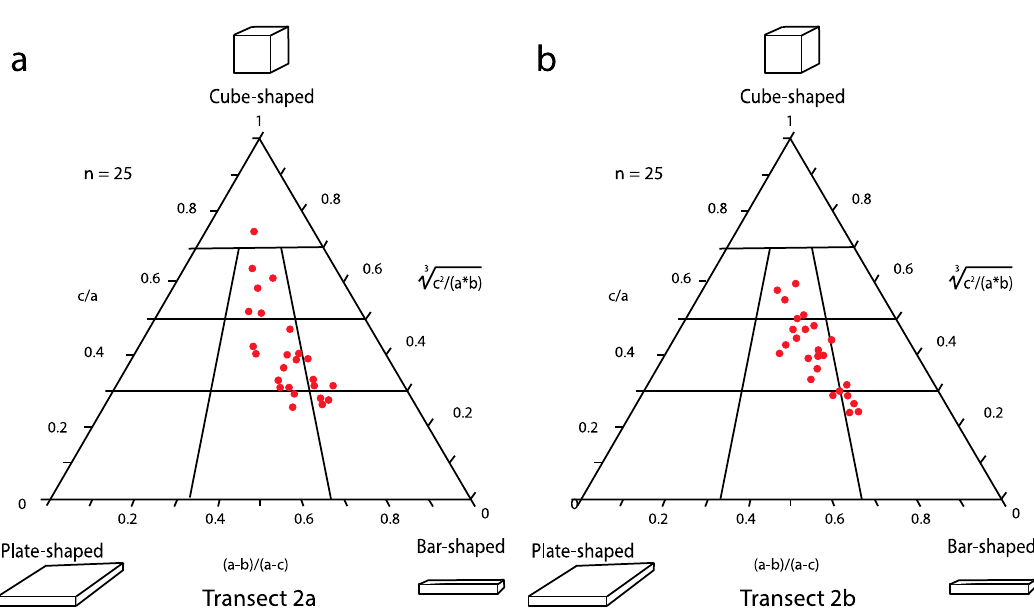
Figure 8. Pair of triangular Sneed-Folk diagrams used to appraise variations in boulder shape on barrier #2; ( a ) Trend for boulders from Transect 2a; ( b ) Trend for boulders from Transect 2b. Note similarities in slopes with those from barrier #1 in Figure 7.